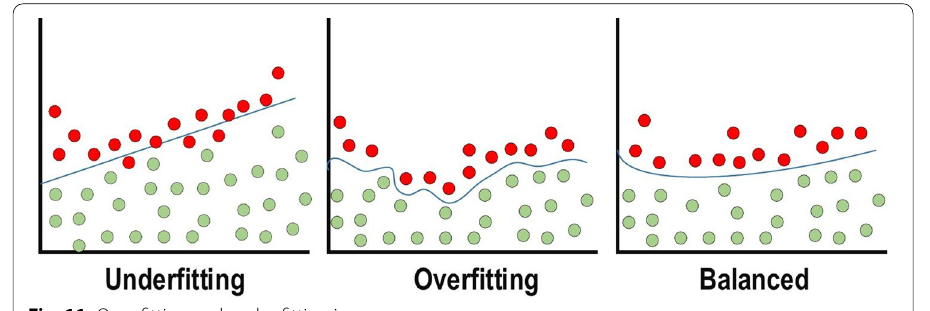
Fig. 11 Over‑fitting and under‑fitting